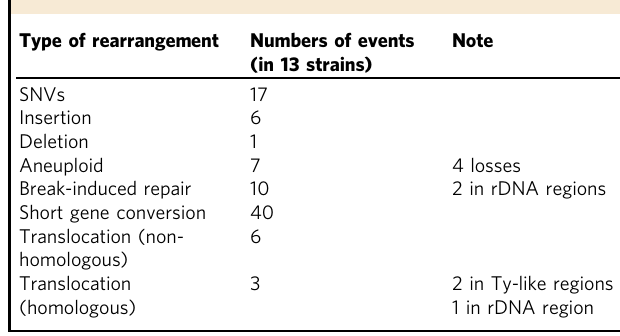
Table 1 Summary of mutation types in Fig.